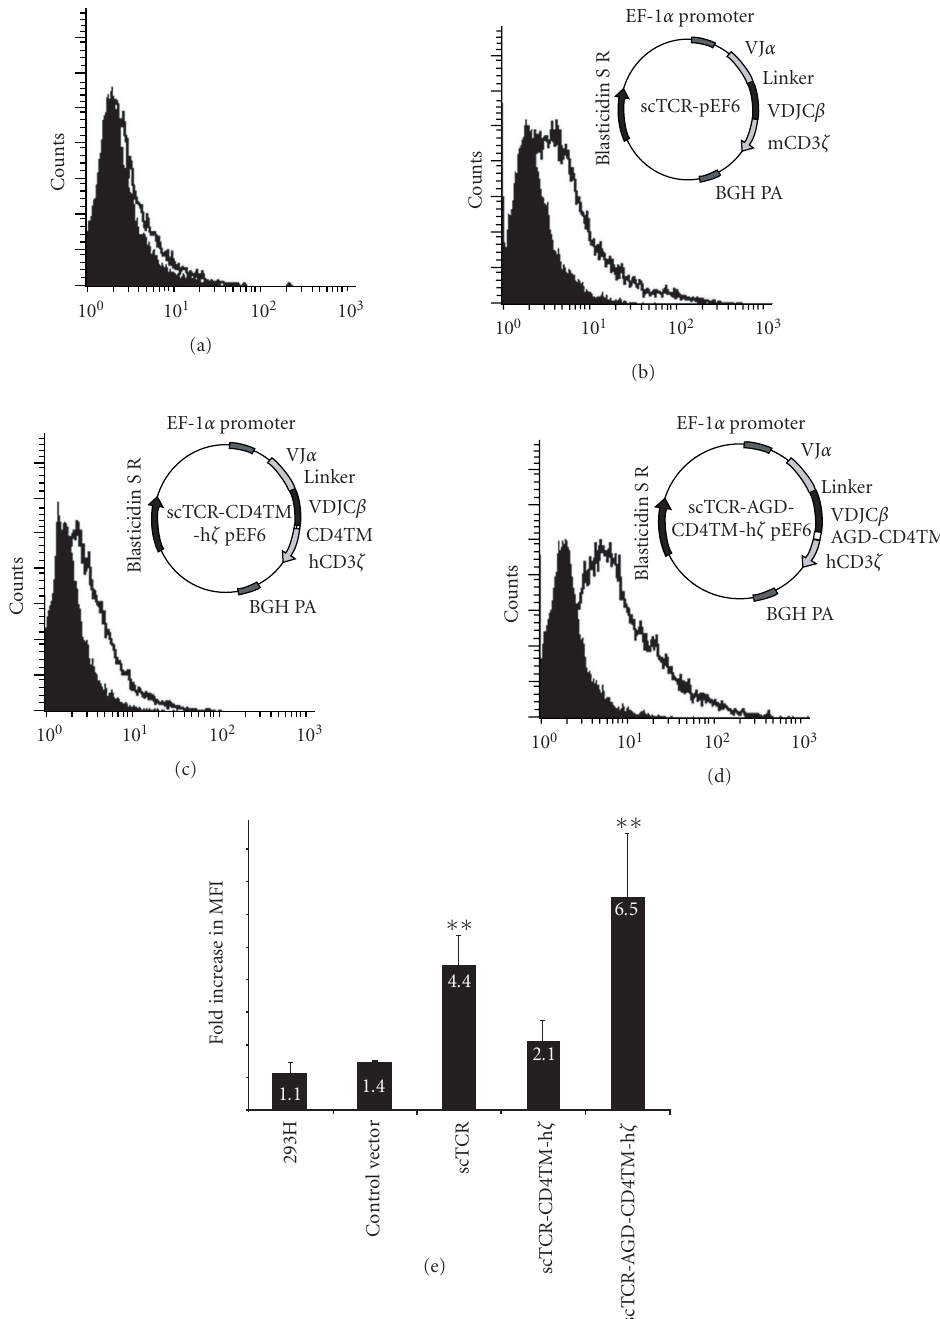
Figure 3: Construction and expression of MUC1-specific single-chain T cell receptors (scTRs) . (a) 293H cells were transfected with (b) the scTR, (c) scTR-CD4TM-hZ, or (d) scTR-CD4TM-AGD-hZ mammalian expression vectors. Cells were stained with anti-TR BF1 (open histogram) or isotype control (filled histogram) antibody. (e) shows quantitative comparison of TR expression on 293H cells transfected with di ff erent scTR constructs. P < .